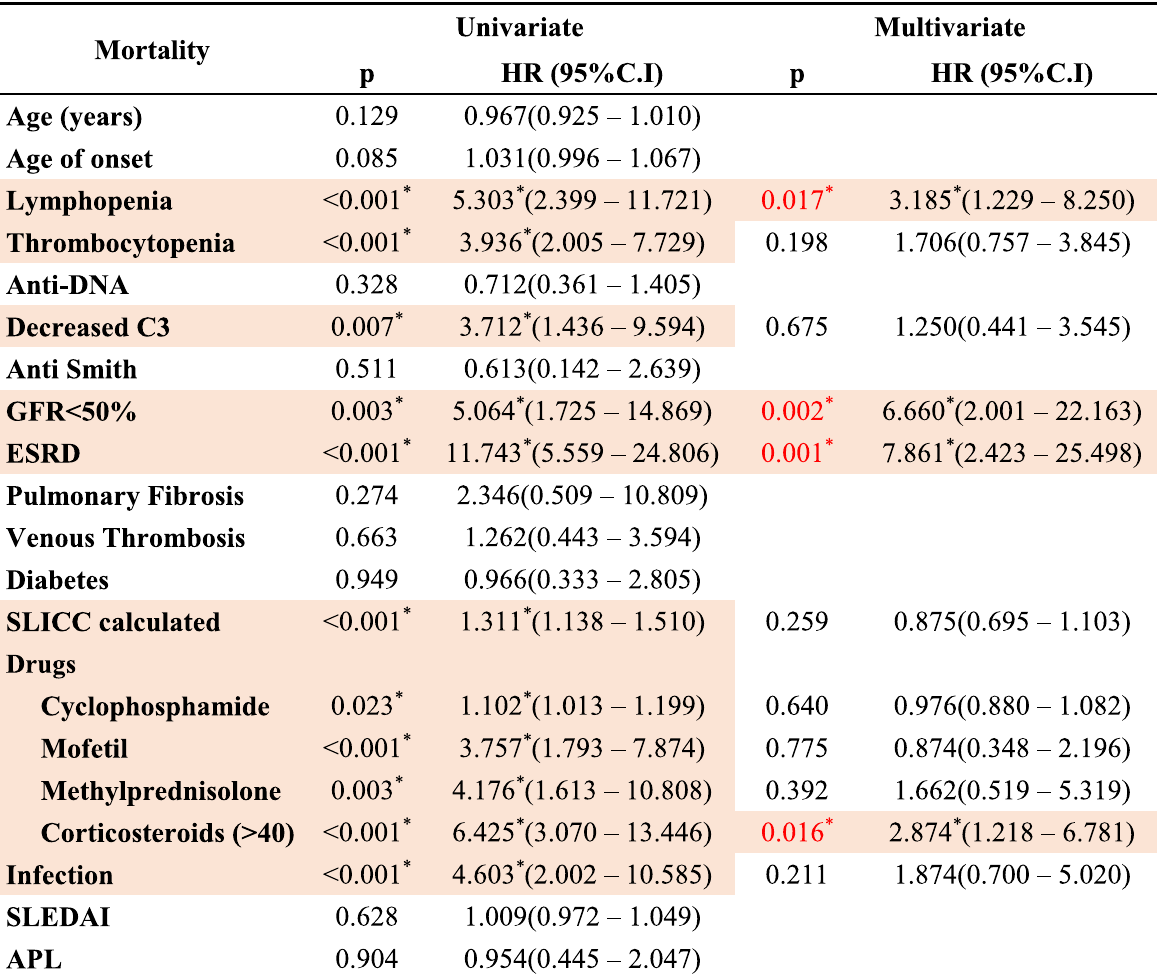
Table 5 Univariate and multivariate Cox regression analysis for the parameters affecting mortality ( n =